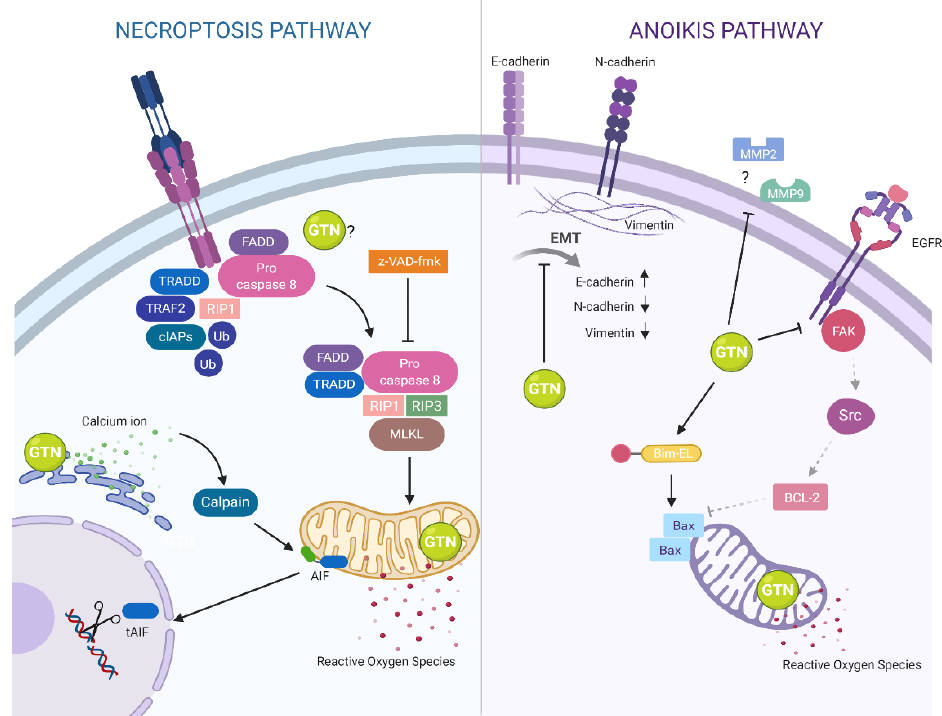
Figure 6. Illustration representing the mechanism of goniothalamin (GTN) co-treated z-VAD-fmk-induced human breast-derived MAD-MB-231 cancer cell necroptosis and anoikis induction in suspension cell culture. GTN induced necroptosis by DNA damage from oxidative stress via an increase of ROS production. GTNdirectlyinducedlipidperoxidationatthecellmembranefromROSproduction, leading to cell membrane rupture. High levels of cytosolic calcium-induced calpain cleave apoptosis-inducing factor (AIF), which translocated to the nucleus for chromatinolysis. z-VAD-fmk also inhibited caspase-8 from executing apoptosis but shifted to necroptosis by the RIP1 / RIP3 forming complex with the MLKL protein leading to mitochondria loss of function. In anchorage-independent growth, GTN abrogated detached-culture MDA-MB231 cells and decreased matrix metalloproteinase (MMP-2 and MMP-9) secretion. GTN induced the detached MDA-MB-231 cells to undergo anoikis via epithelial-mesenchymal transition (EMT) by increased E-cadherin protein and decreased N-cadherin and vimentin levels. GTN also inhibited survival signaling through EGFR / FAK / Src and induced expression of the pro-apoptotic protein, Bim-EL, which led to apoptosis-like programmed cell death,